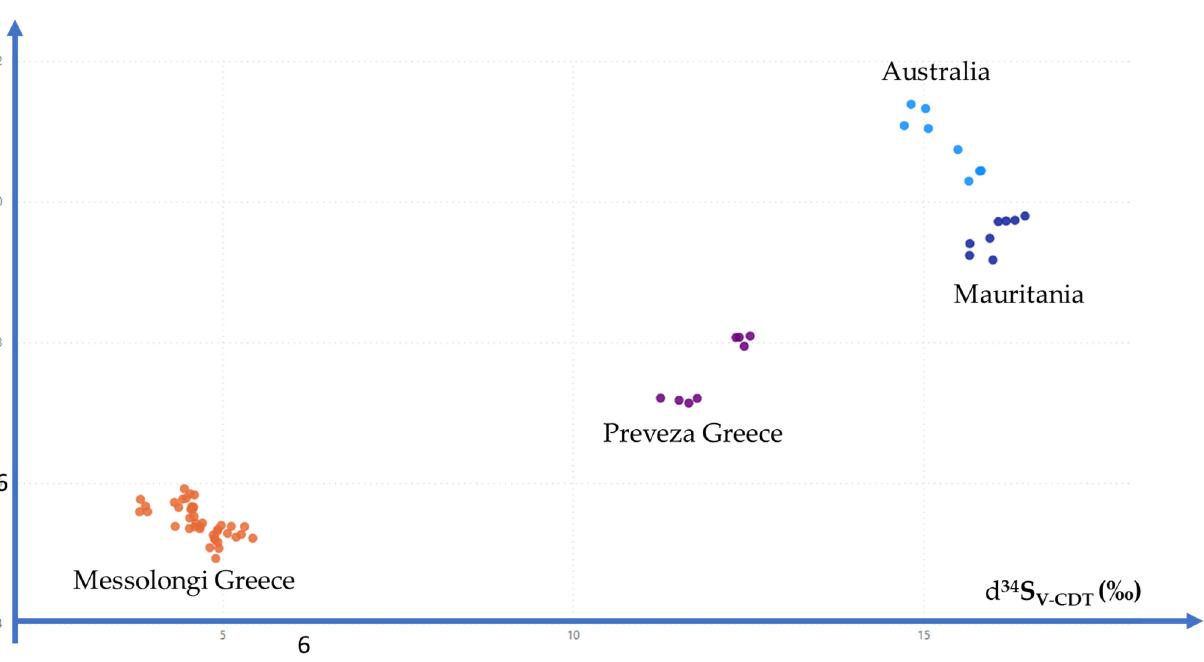
Figure 5. Decision criterion to determine geographic origin of the Greek Bottarga (Fish—Roe) Reg- istered PDO ‘Avgotaracho Messolongi ou’. 4. Conclusions Stable isotope analysis has been used in many products to authenticate their geo- graphical origin. However, there are only a few studies that have been conducted for sea- food origin and especially for mullet roes and bottarga products. This study tried to in- vestigate the geographical origin of different bottarga products by means of verifying the authenticity of the Greek Bottarga product named ‘Avgotaracho Messolongiou’ the only Greek product registered as a Protected Designations of Origin (PDO). The results of the